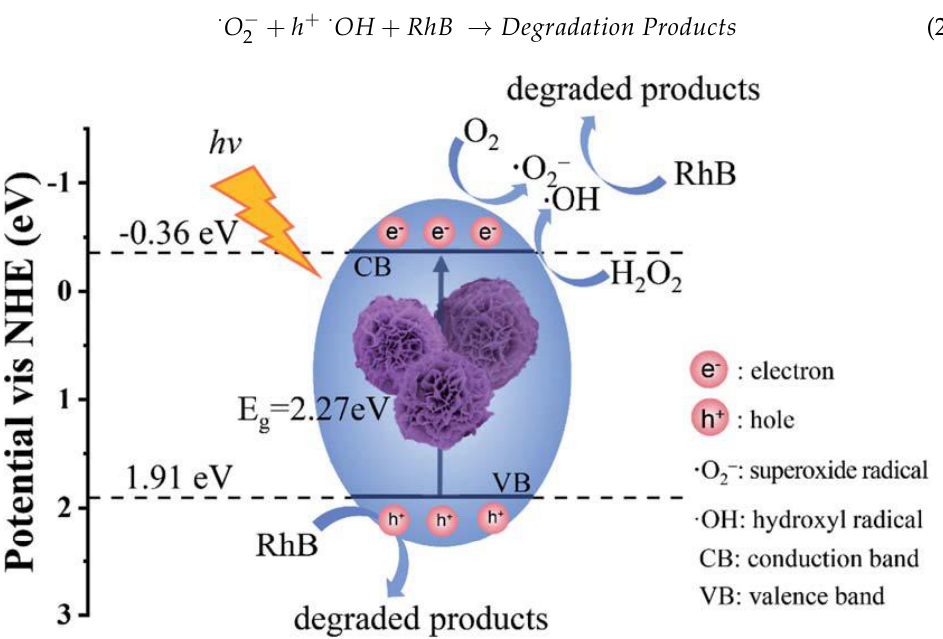
Figure 12. The mechanism for photocatalytic degradation of RhB via MOFs. Reprinted from ref. [178] with permission.